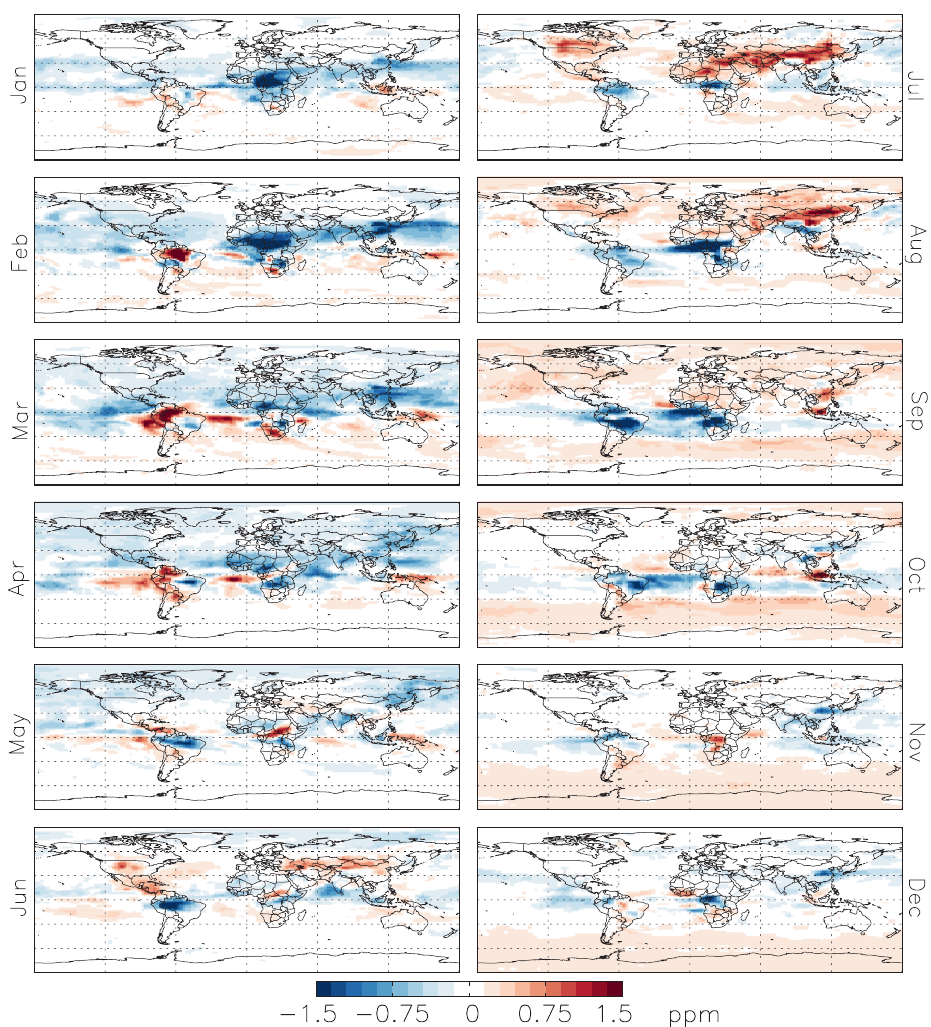
Fig. 17. Monthly-averaged CO 2 difference plots from simulations with different meteorological fields (GEOS-5 and GEOS-4) for 2006 at the level near 5km. The runs began on 1 January 2004 with identical conditions and were exposed to identical fluxes (without the chemical